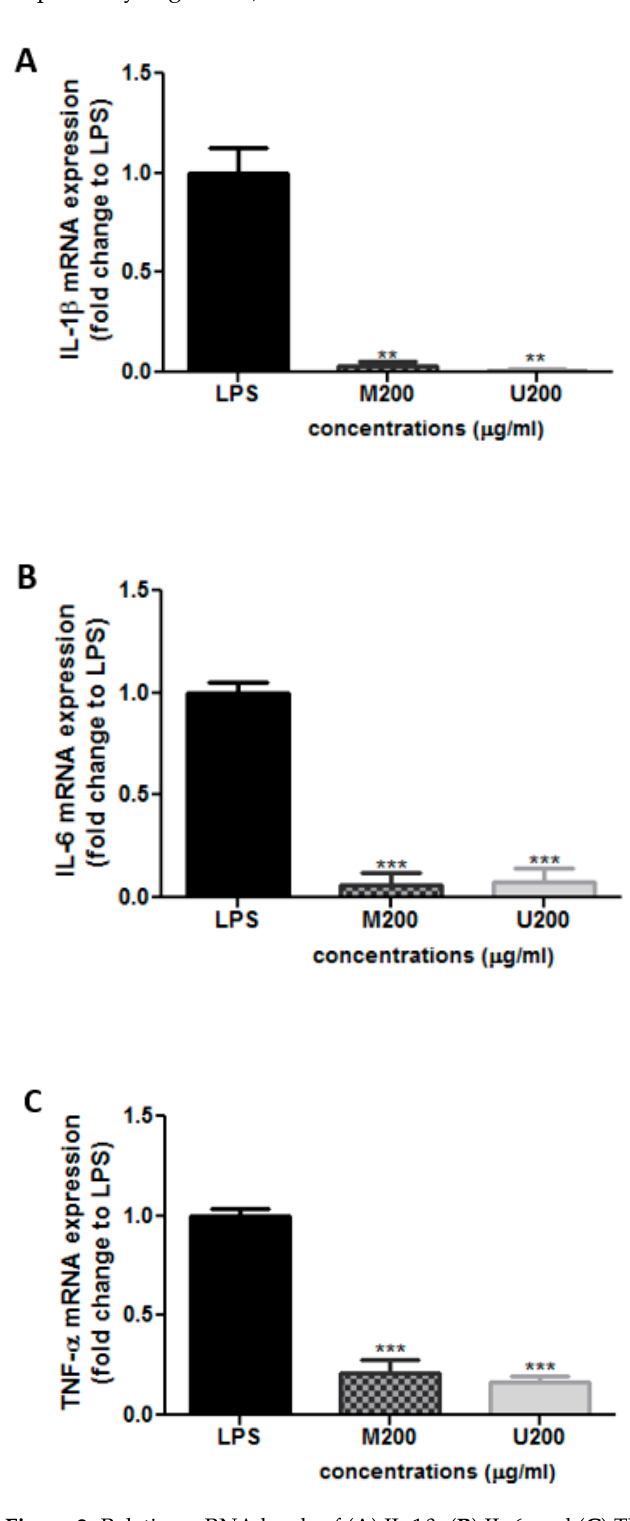
and ultrasound crude extracts on COX-2 protein levels (94.2 ± 1.3% and 94.4 ± 1.1% respectively, Figure 3B).